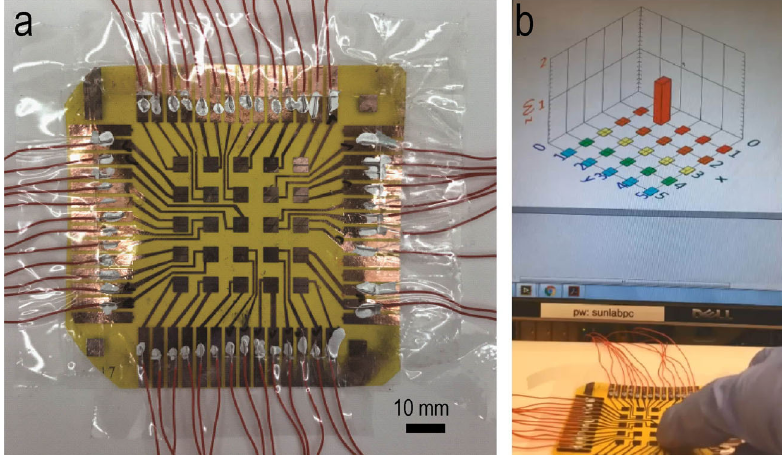
Fig. 5 a Photograph of the GST-based 5 × 5 sensor array on fl exible PET foil (scale bar, 10 mm). b 3D illustration of the electrical response of sensor with touching behavior